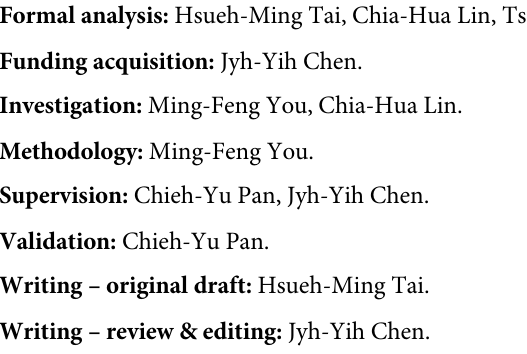
S1 Table. Proximate analysis of basal feed with additive compositions at the early, middle and late stages. S2 Table. Formulation of the basal diet at the early, middle and late